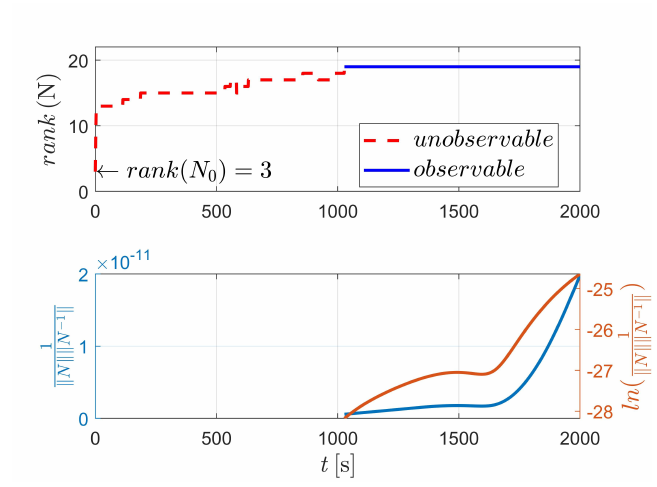
Figure 17. Observability simulation of case V (with nonperturbation).